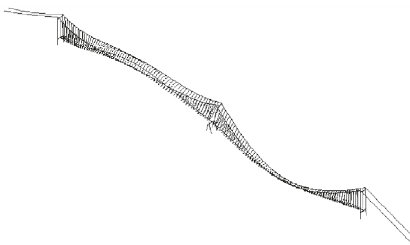
Figure 11: Aerostatic instability form of TYB under an initial attack angle of 0 ∘ .